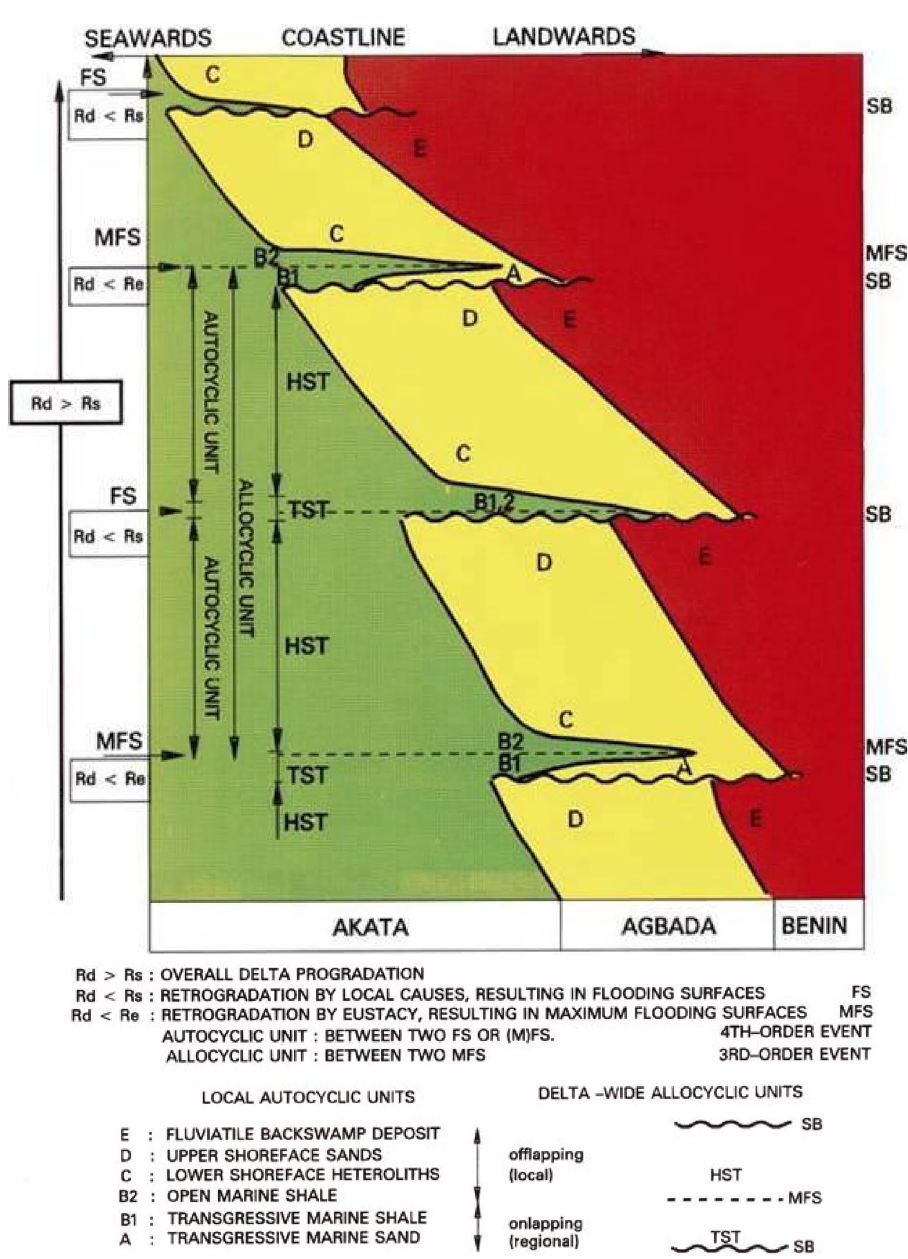
Fig. 2 Mechanisms and units of delta evolution (after Reijers